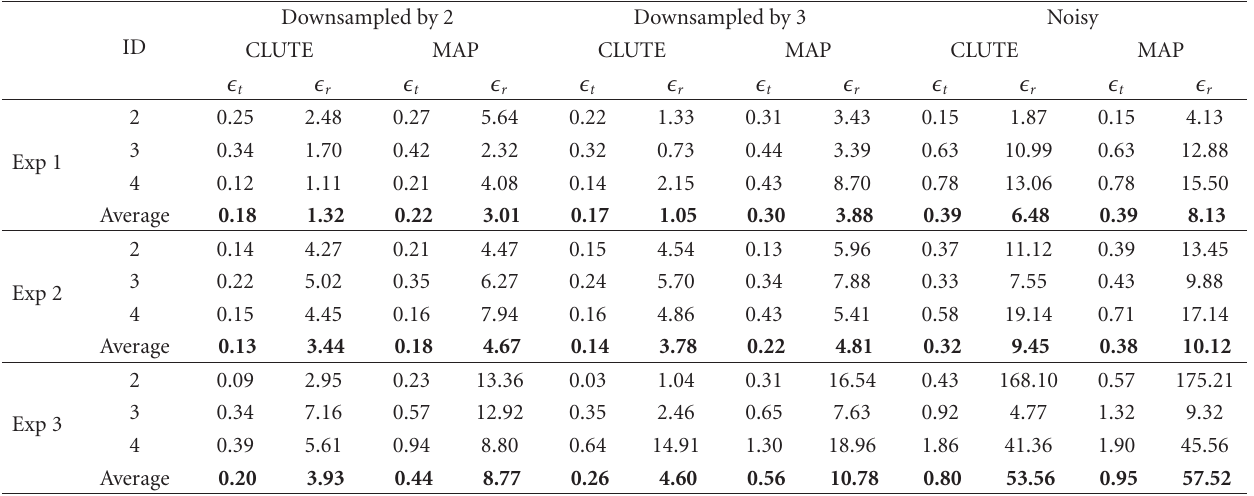
Table 3: Performance comparison between CLUTE , MAP , and MDS on the three datasets for missing and noisy data (4-camera network).